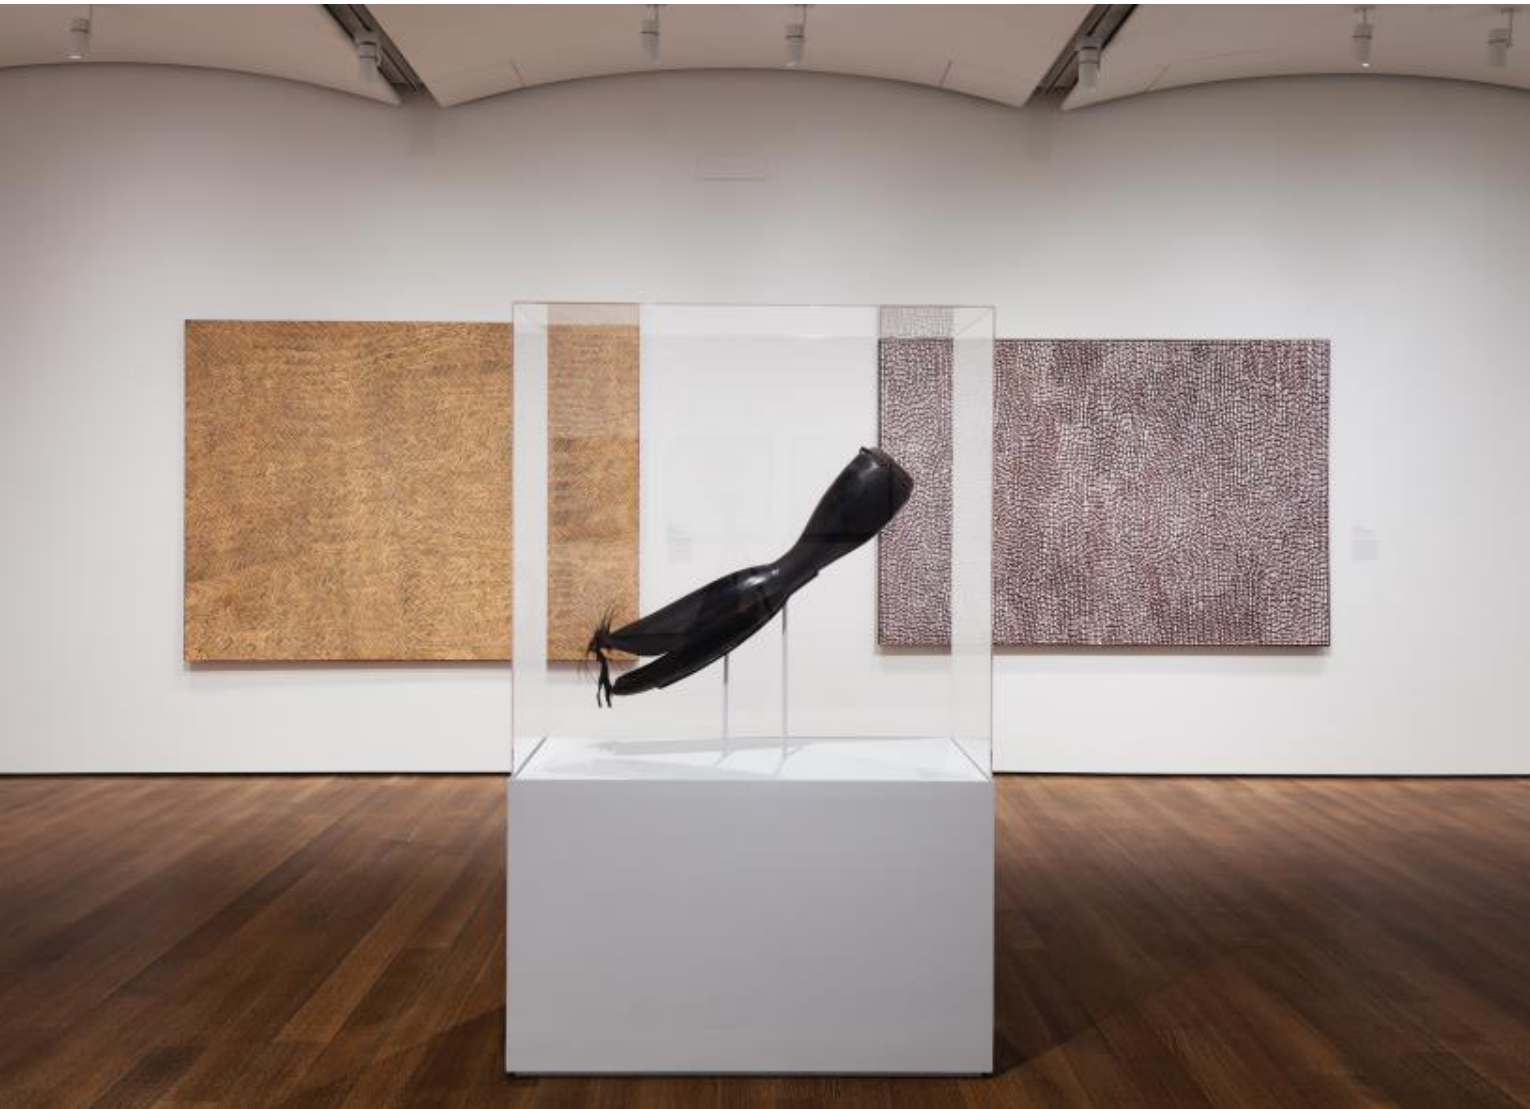
Figure 4 Installation view of “Performance” module from Everywhen: The Eternal Present in Indigenous Art from Australia, Harvard Art Museums, Cambridge, MA, curated by Stephen Gilchrist. Works left to right: Doreen Reid Nakamarra, Untitled , 2007; Unidentified artist, Warup (Drum) , mid-19th — early 20th century; and Dorothy Napangardi, Karntakurlangu Jukurrpa , 2002. Image Courtesy Harvard Art Museums, © President and Fellows of Harvard